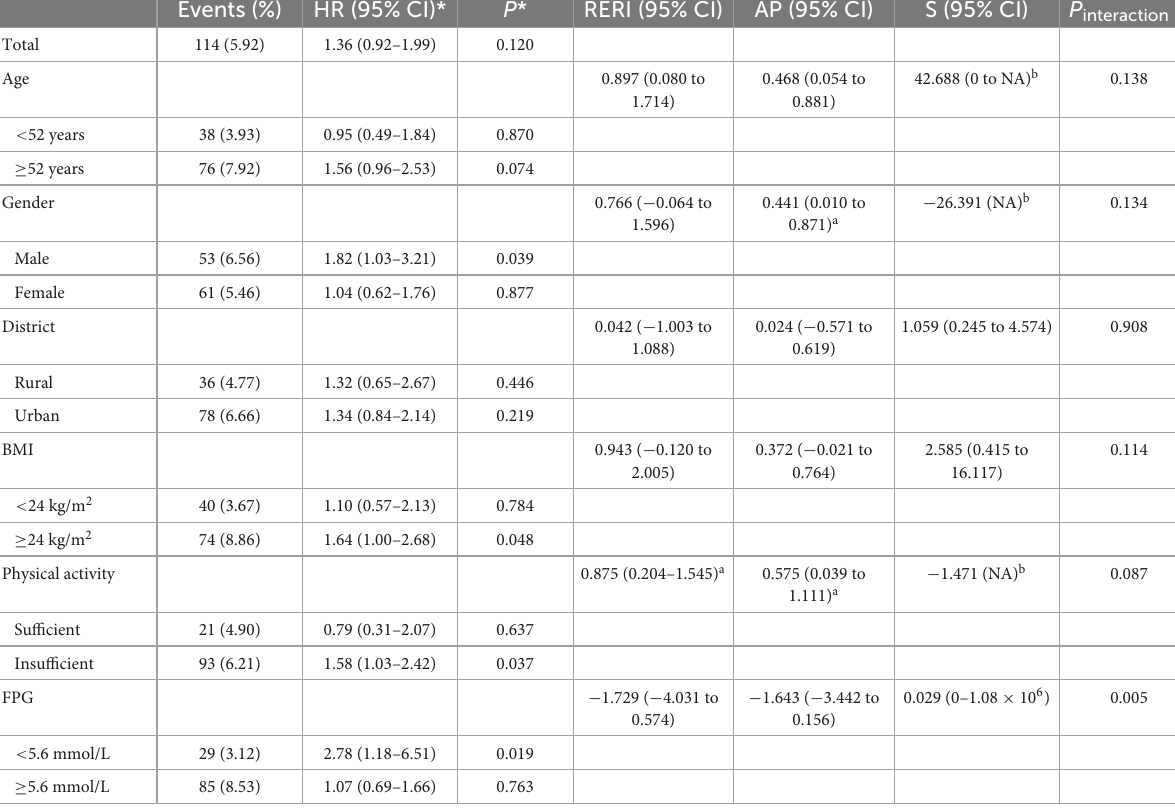
TABLE 4 Interactions between serum 25(OH)D and established risk factors on type 2 diabetes